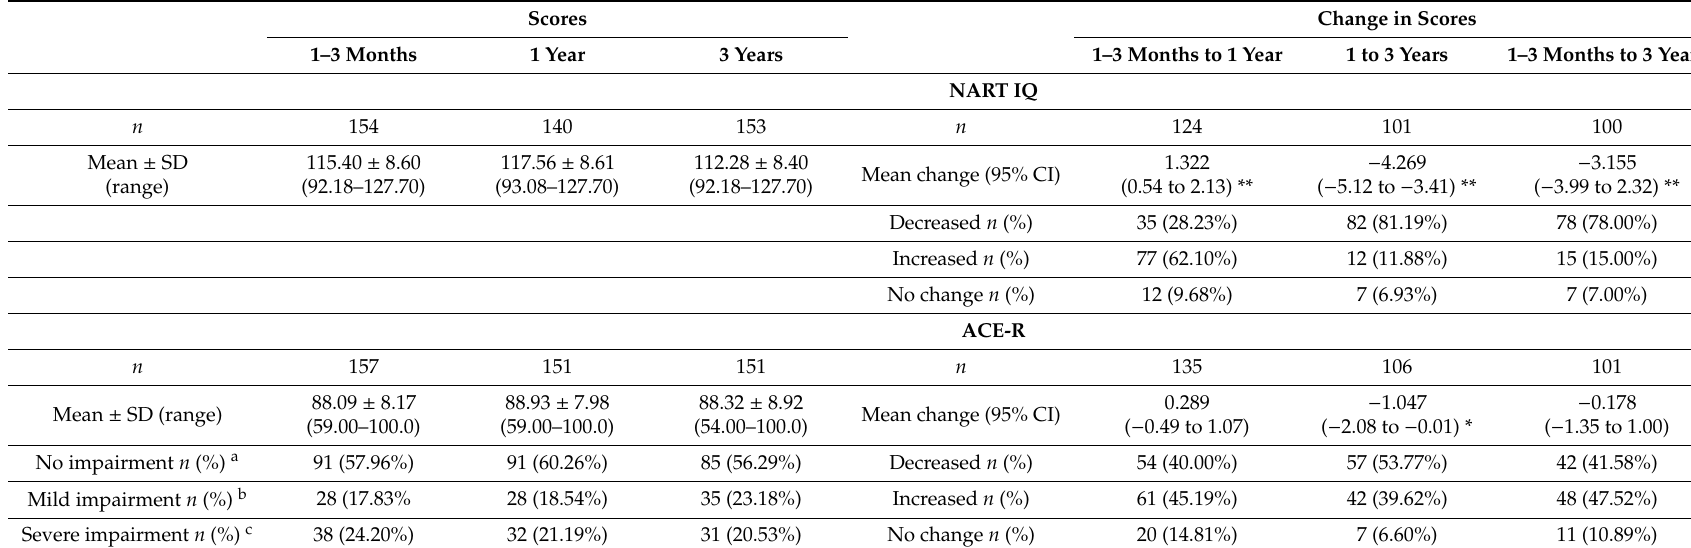
Table 2. NART IQ and ACE-R scores at and between each time-point for all patients with data available at each